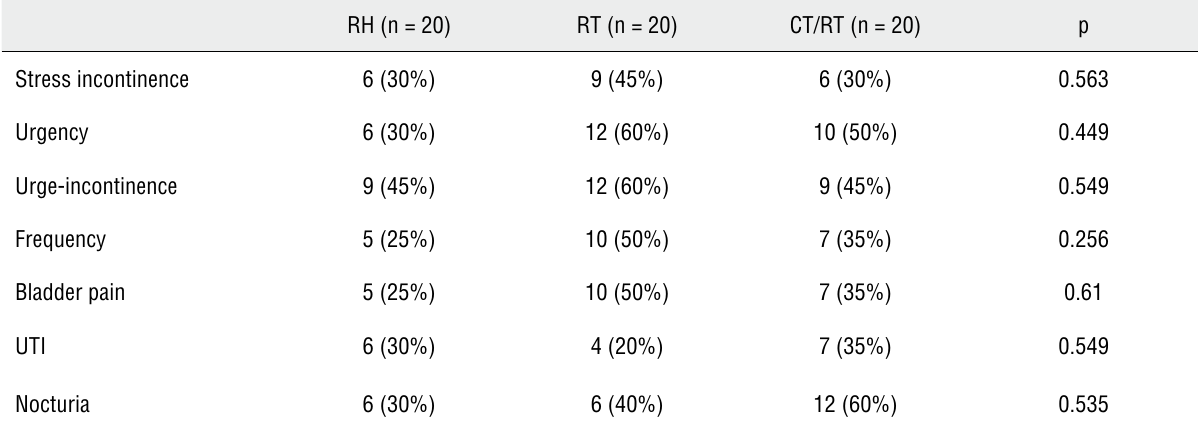
Table 2 - Urinary symptoms according to treatment